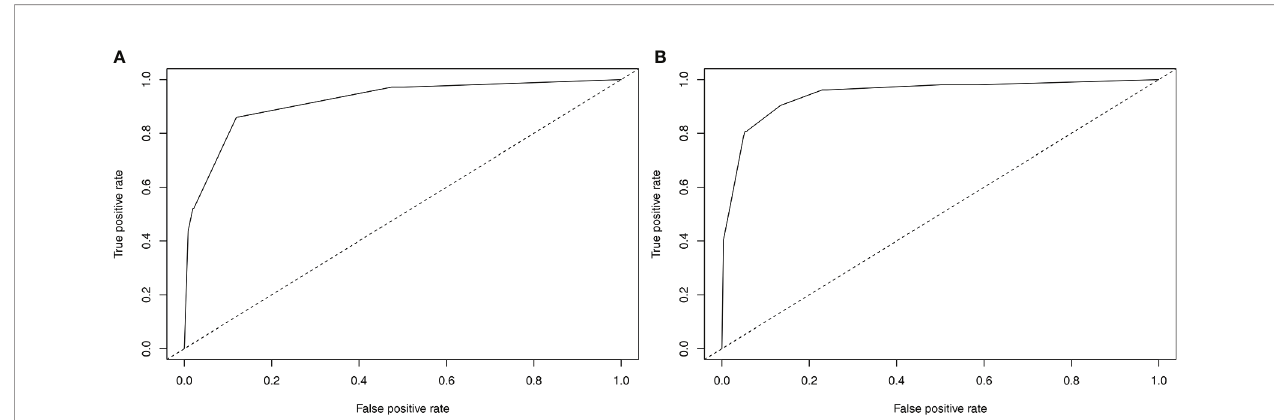
FIGURE 4 | Validation of the nomograms to predict hemophagocytic syndrome in patients with nasal-type, extranodal nature killer/T-cell lymphoma: the area under the receiver operating characteristic curve was 0.919 for RINK (A) and 0.946 for RINK-E (B)